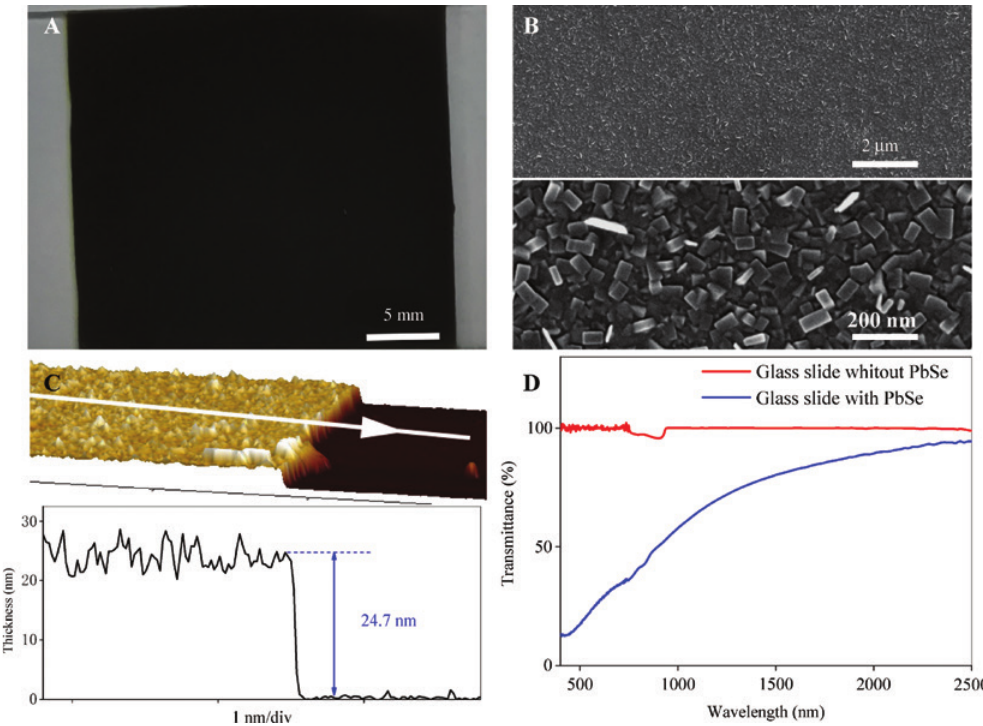
Figure 1: Surface morphology and transmission characterization of PbSe films. (A) Photograph, (B) SEM image, and (C) AFM image of the PbSe films deposited on glass slide. (D) Linear transmission spectrum of the glass slide before and after depositing PbSe